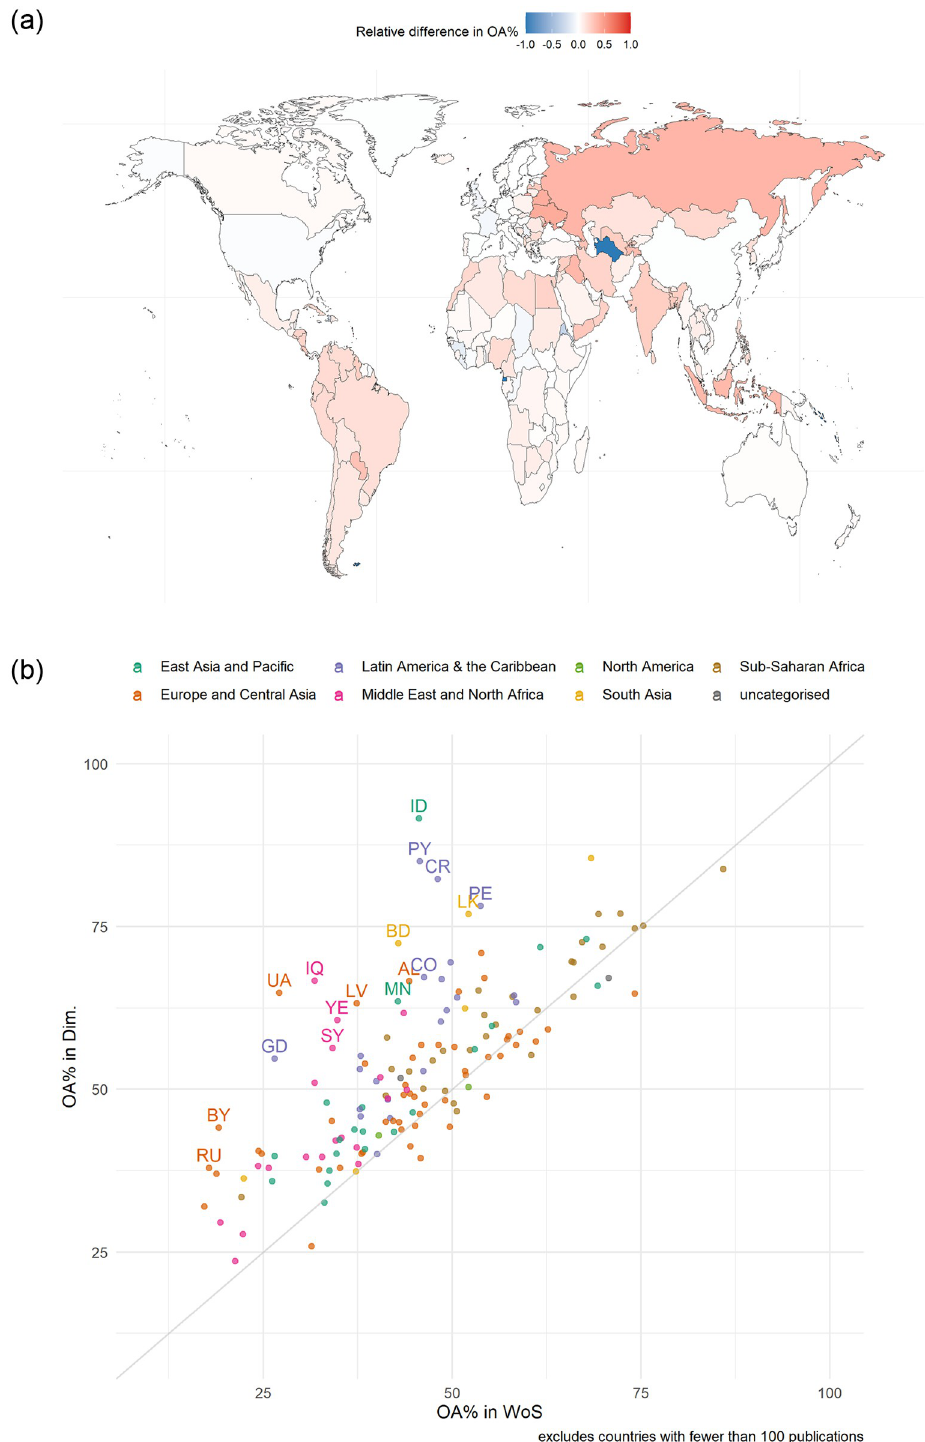
Fig 4. A) Relative difference in percentage of open access publications between Dimensions and WoS, by country, 2015–2019, B) Scatterplot of the percentage of open access publications for Dimensions and WoS, by country and region (includes only countries with more than 100 publications, ISO 2 code for countries with 20 < percentage point difference), 2015–2019.